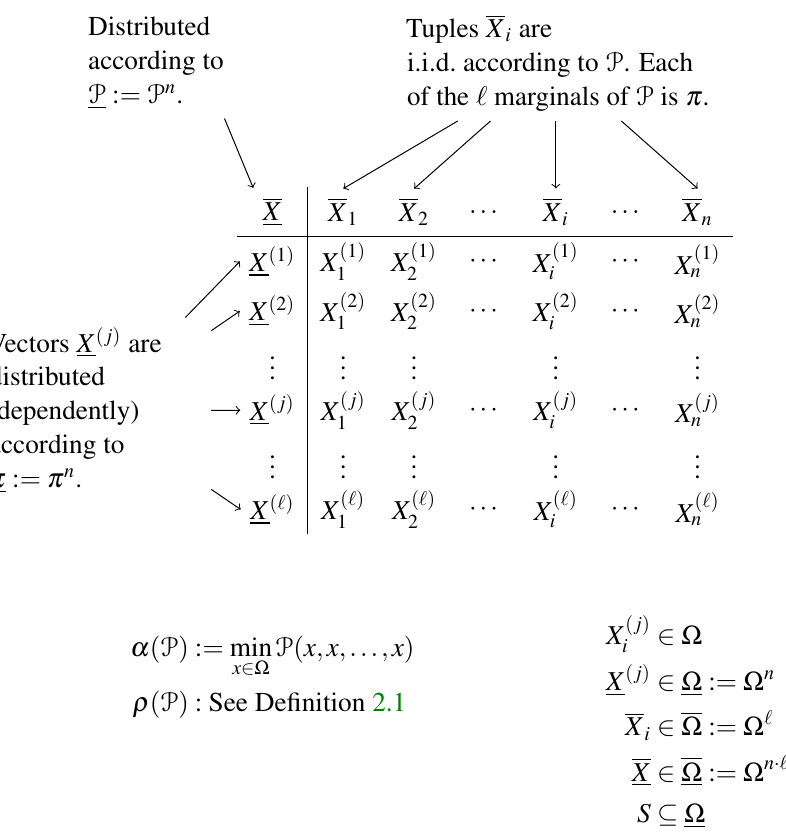
Figure 1: Naming of the random variables in the general case. The columns X i are distributed i.i.d ac- cording to P . Each X ( j ) is distributed according to π . The overall distribution of X is P i